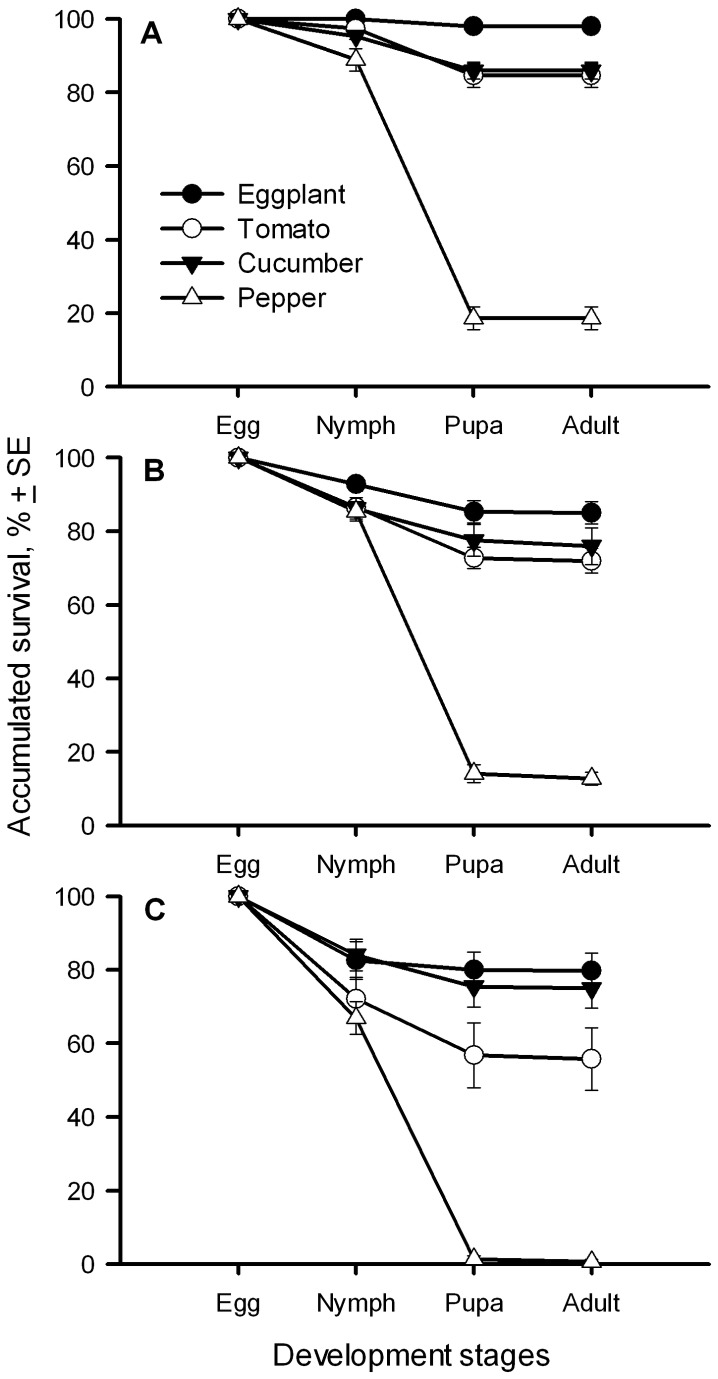
Survivorship (% ± SE) of B. tabaci immatures reared on four host plants.A, B and C represented for the immatures of Bemisia-eggplant, Bemisia-tomato, and Bemisia-cucumber, respectively.